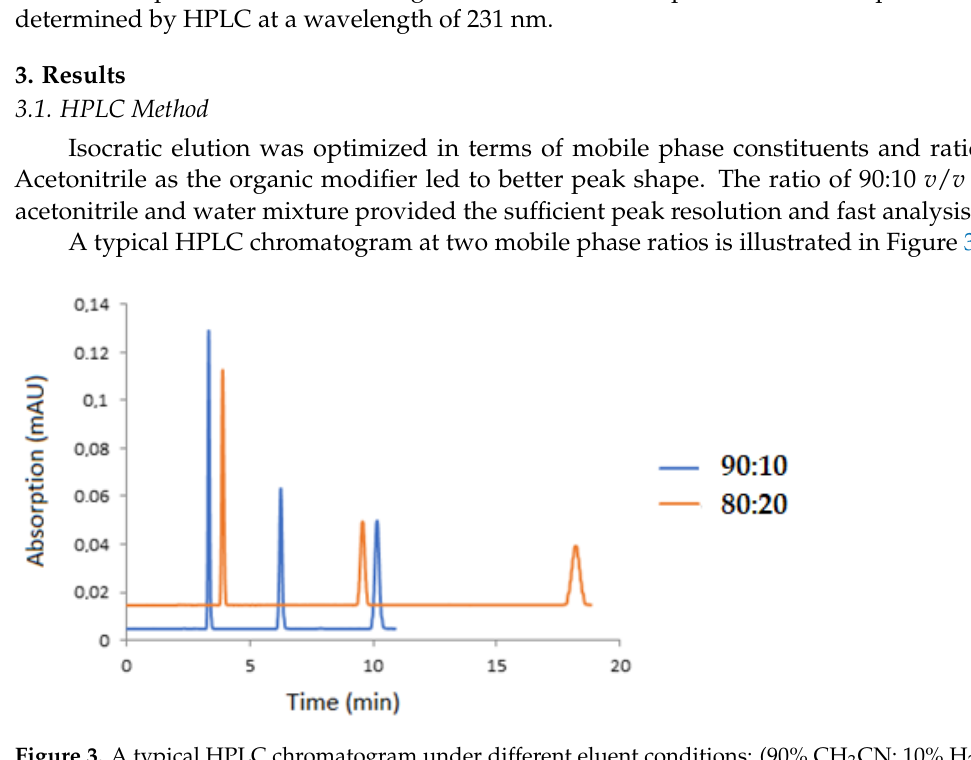
Figure 3. A typical HPLC chromatogram under different eluent conditions: (90% CH 3 CN: 10% H 2 O v / v , peaks: DBT-sulfone 3.89 min, DBT 9.59 min, and 4,6-DMDBT 18.26 min) and (80% CH 3 CN: 20% H 2 O v / v , peaks: DBT-sulfone 3.33 min, DBT 6.25 min, and 4,6-DMDBT 10.20 min).